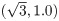
a) Chaos and order in a hexagon with cities of equal masses, with the following parameters: μ = 0.09, m = 1, k = 1, and h = 0.02, which will be described below. Cities, indicated by black circles, have the following coordinates: (3,1.0), (0.0,2.0), (-3,1.0), (3,-1.0), (0.0, −2.0),and (-3,-1.0). The distance between neighbouring cities is 2; b) three trajectories; c) transition to order in hexagonally-placed cities with μ = 0.7.